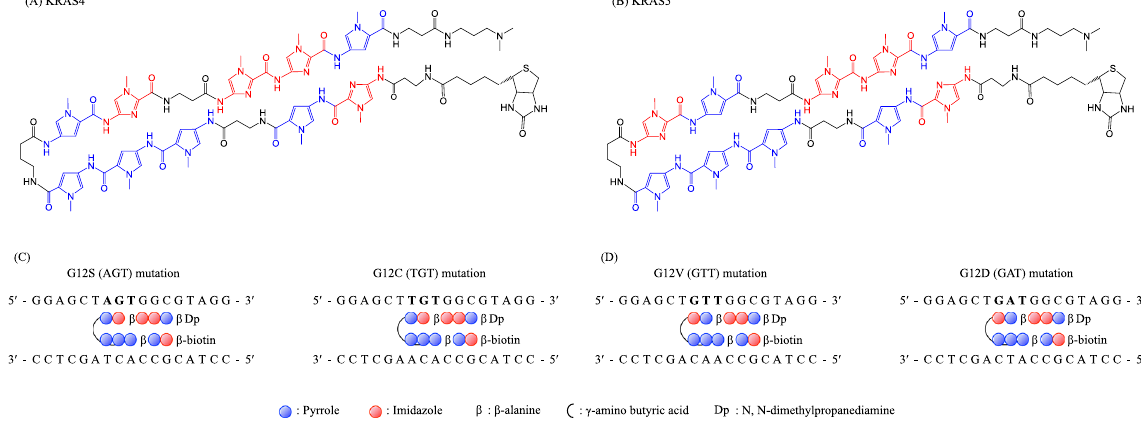
Figure 3. Structure of biotinylated pyrrole–imidazole polyamides. ( A ) Chemical structure of the PI polyamide, KRAS4. ( B ) Chemical structure of the PI polyamide, KRAS5. ( C ) KRAS4 targets G12S/G12C mutations. ( D ) KRAS5 targets G12V/G12D